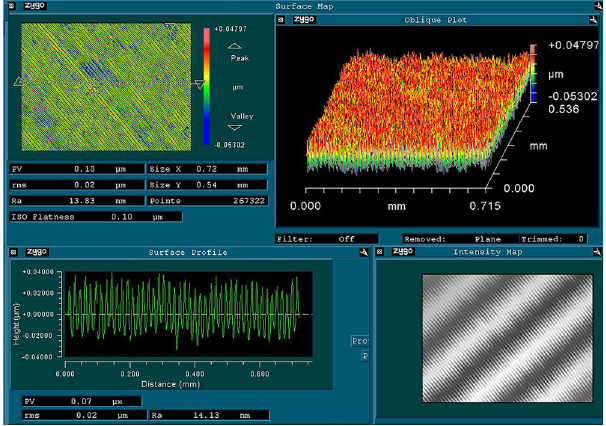
FIG. 21. Results of the interferometric probing of the precision turned copper surface (courtesy of VDL [58]).